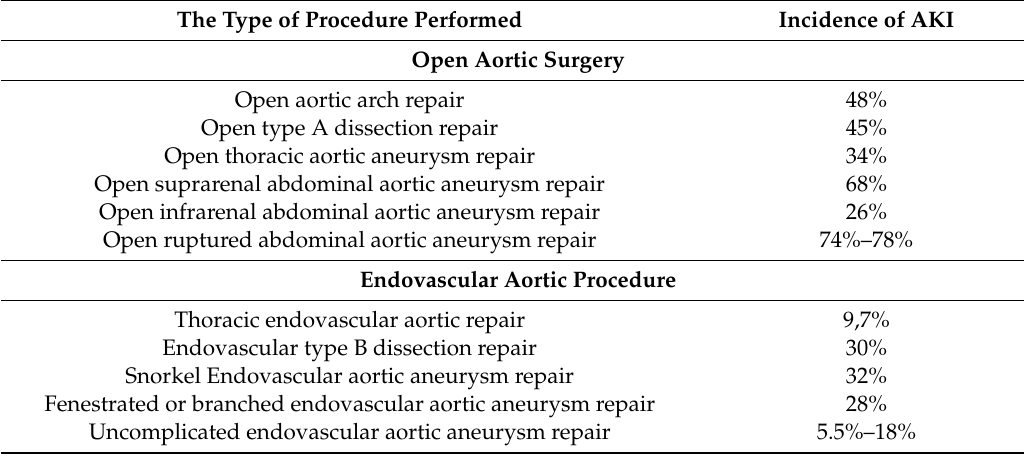
Table 2. Incidence of AKI by anatomic location of vascular procedure [26,30–32,37,38]. The Type of Procedure